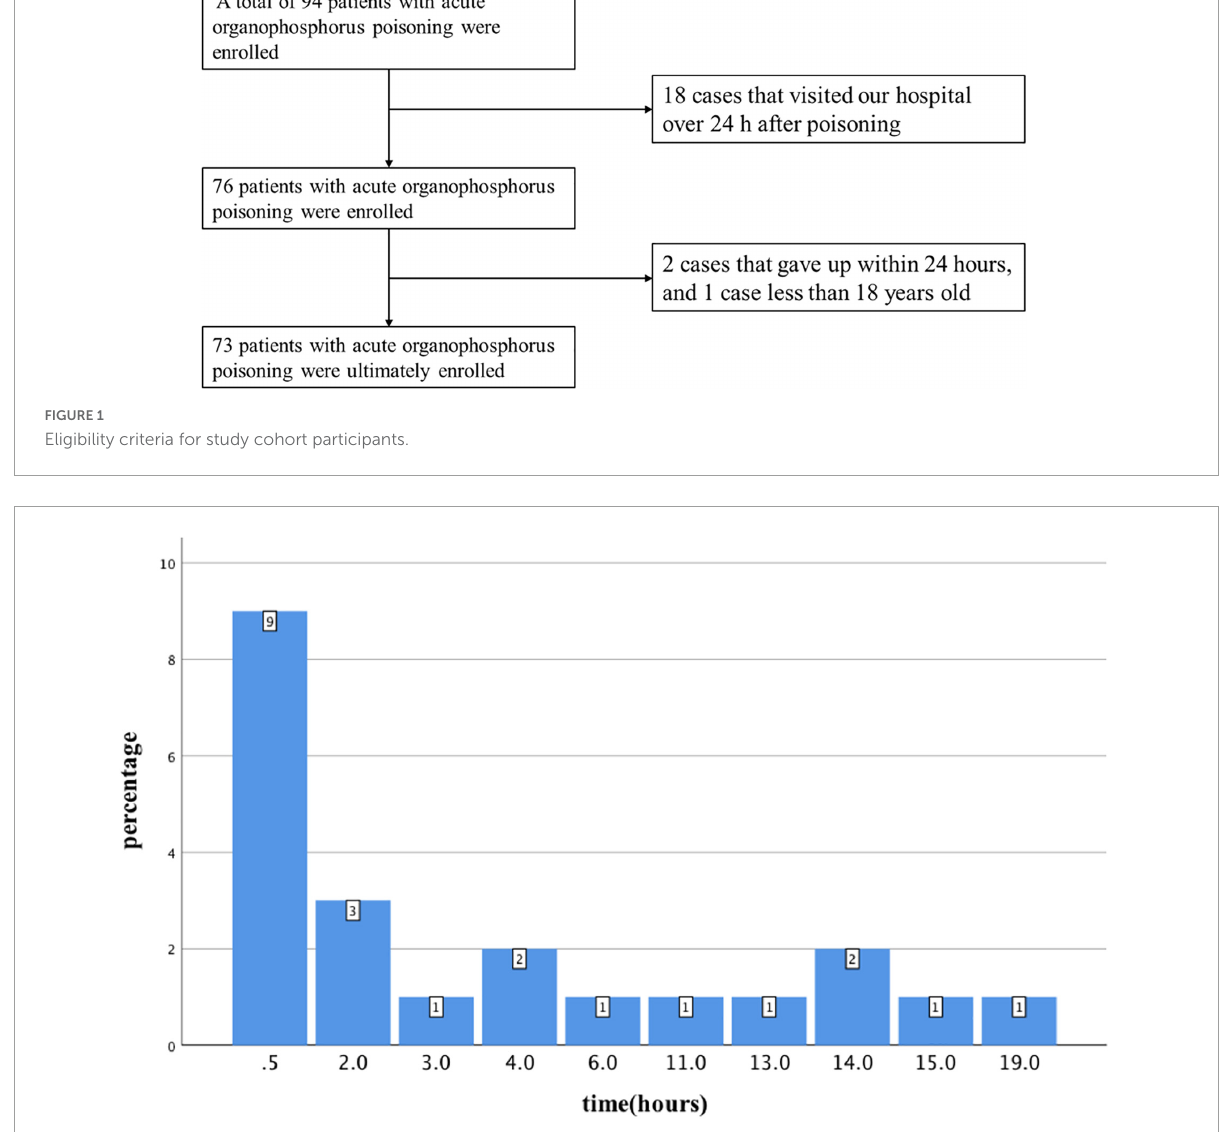
FIGURE2 Histogram of the occurrence time of organophosphorus poisoning-induced